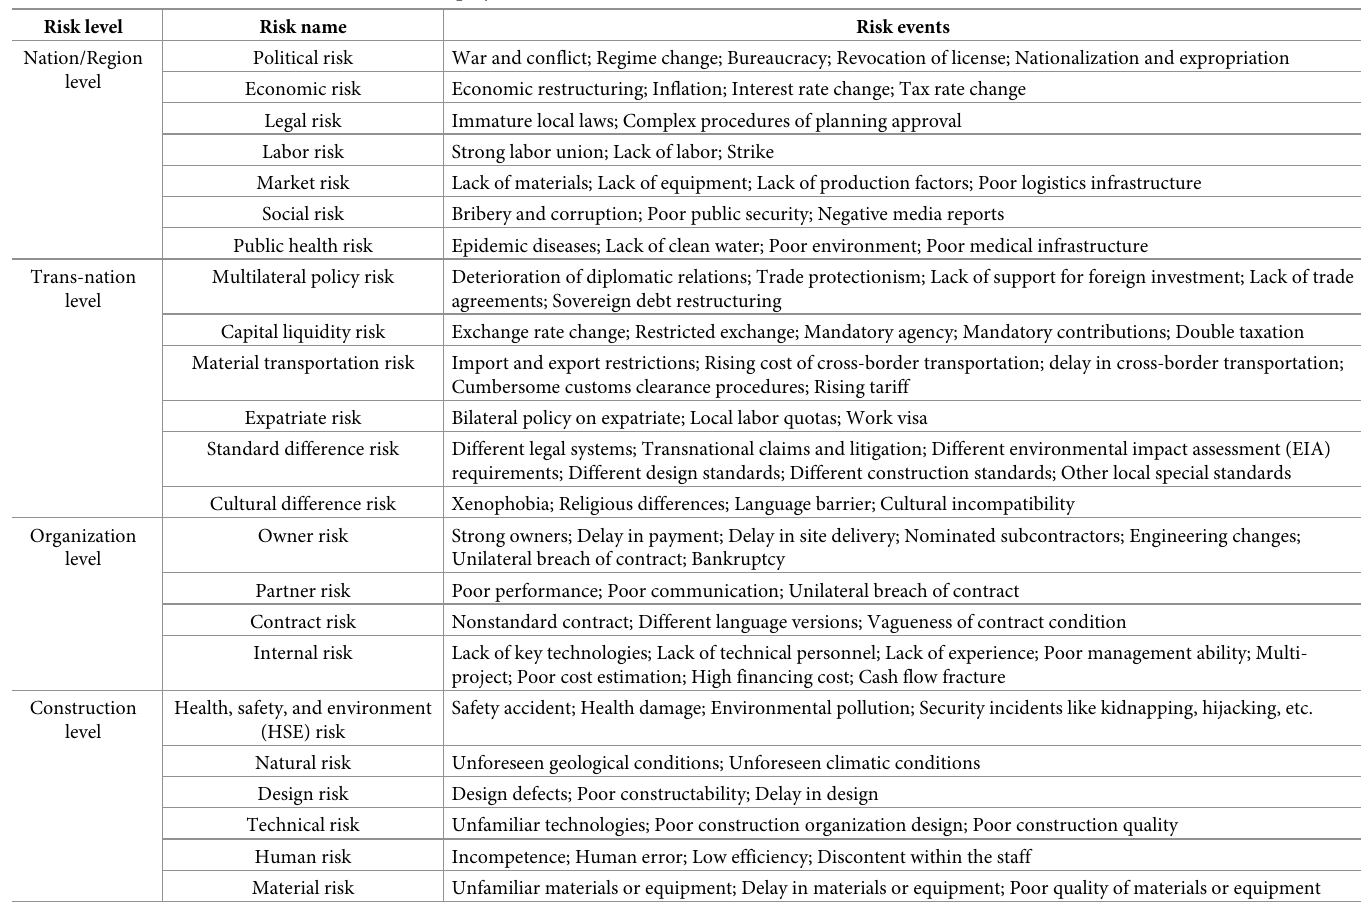
Table 2. Risk checklist for international construction